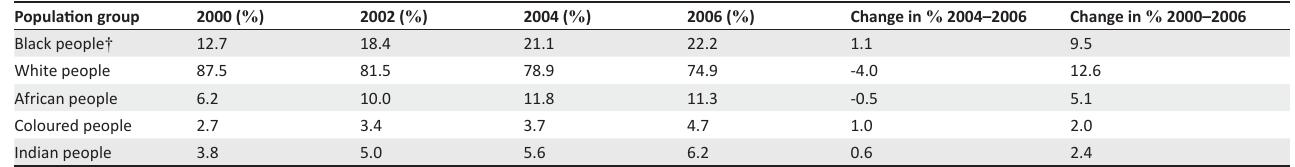
TABLE 4: Comparative changes at the top management level from 2000 to 2006. Population group White